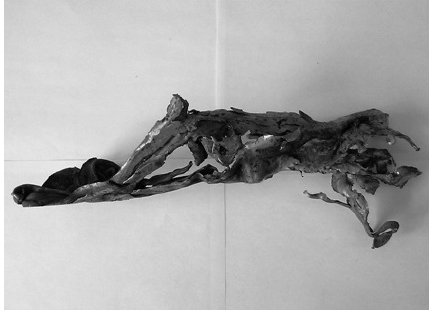
Figure 4. A liner fragment after experimental